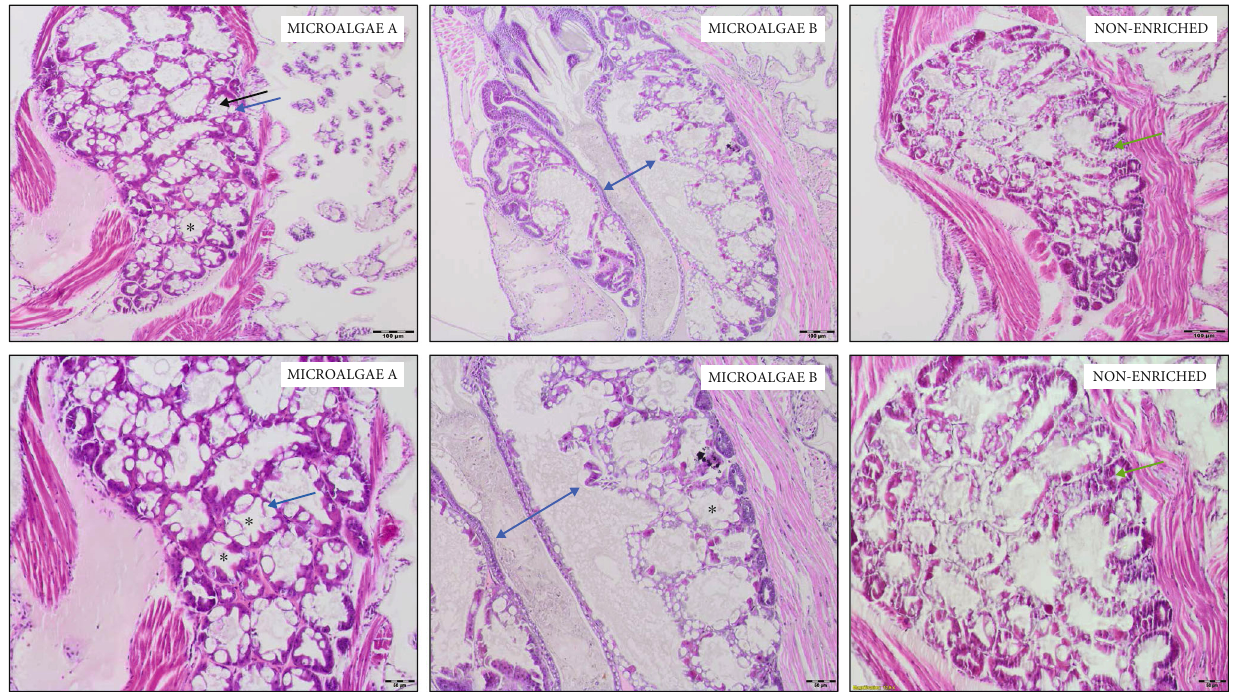
Figure 1: Photomicrograph of a longitudinal section of hepatopancreas from postlarvae fed with di ff erent enriched and unenriched Artemia . Microalgae A: large number of B cells (blue arrow), well-developed tubules (black arrow), and clearly dilated tubules (asterisks). Microalgae B: increased number of vesicles around B cells are obvious, healthy, and dilated tubules (asterisks). The central tube was also dilated (double blue arrow). Nonenriched: fewer B cells and presence of degenerated tissue (green